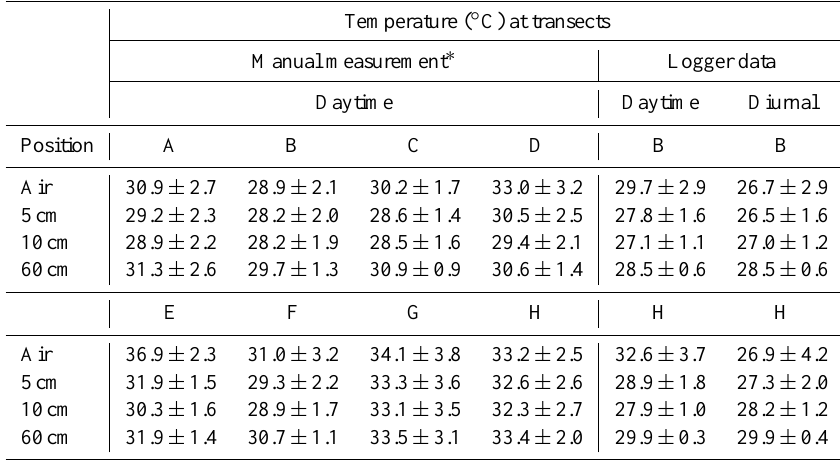
Table 3. Temperatures (mean ± SD) of air close to the peat surface, and at depths of 5, 10, and 60cm into the peat based on manual measurements at daytime during CO 2 flux monitoring and diurnally collected logger data. Temperature ( ◦ C) at transects Manual measurement ∗ Logger data Daytime Daytime Diurnal Position A B C D B